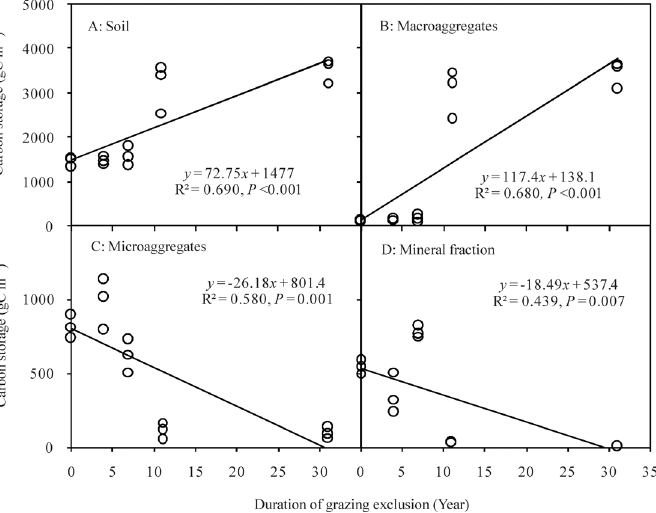
Fig 4. Carbon storage in soil aggregates with grazing-exclusion duration in the Inner Mongolian